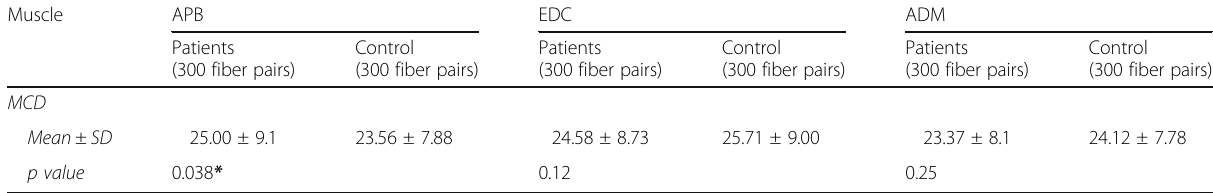
Table 2 MCD of the APB, EDC, and ADM